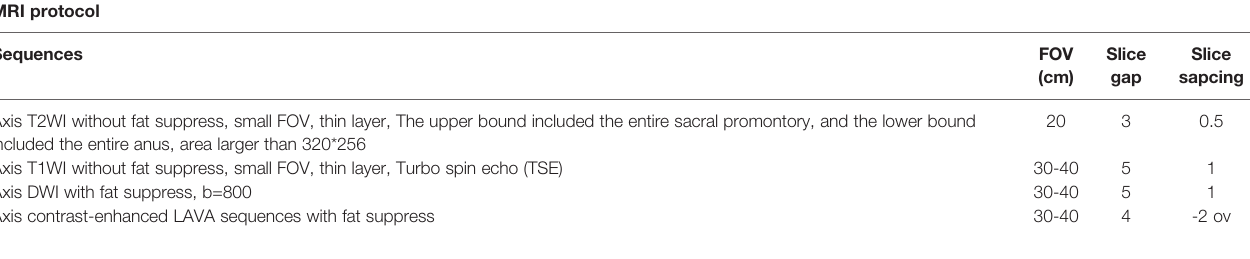
TABLE 1 | Detailed MRI